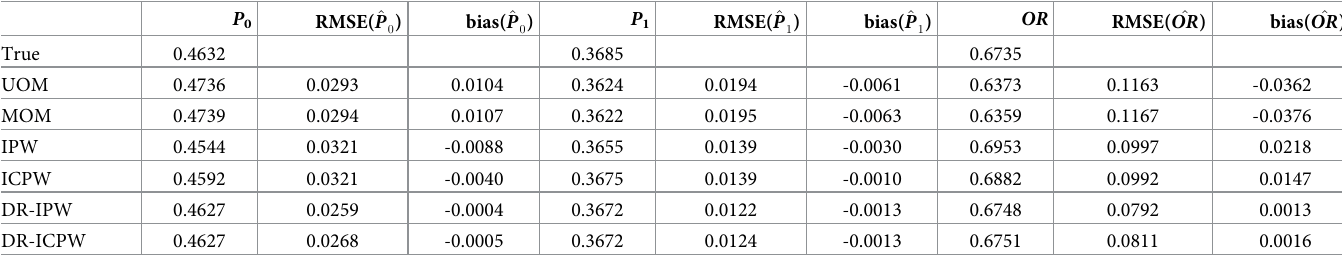
Table 8. Result of scenario 3, a general simulation